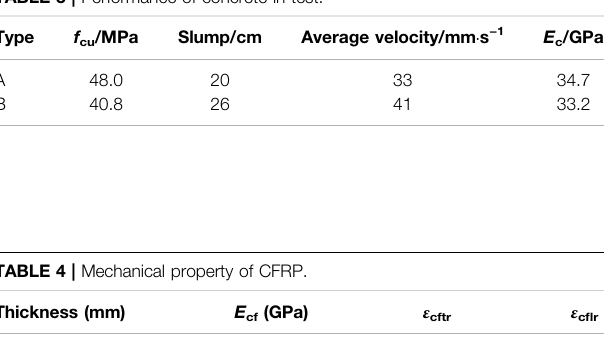
TABLE 3 | Performance of concrete in test.